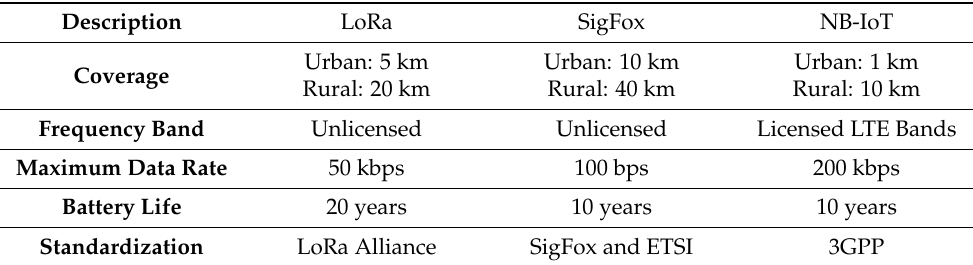
Table 1. Comparison of LPWAN wireless technologies. Description